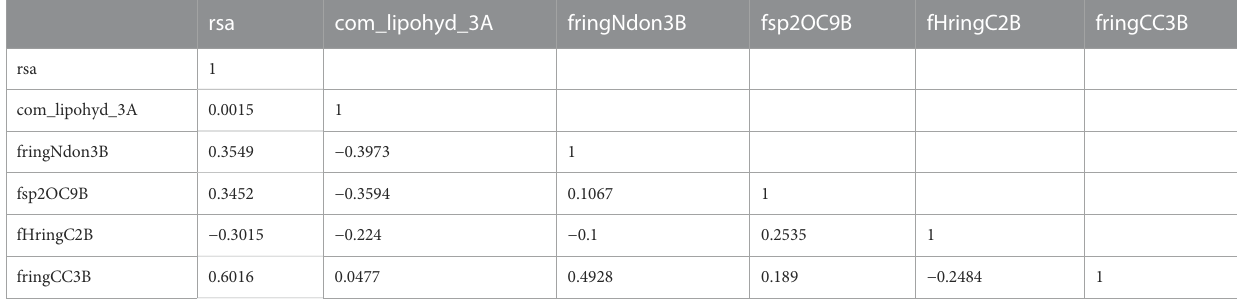
TABLE 2 Presentation of the correlation matrix for the descriptor used to developed QSAR